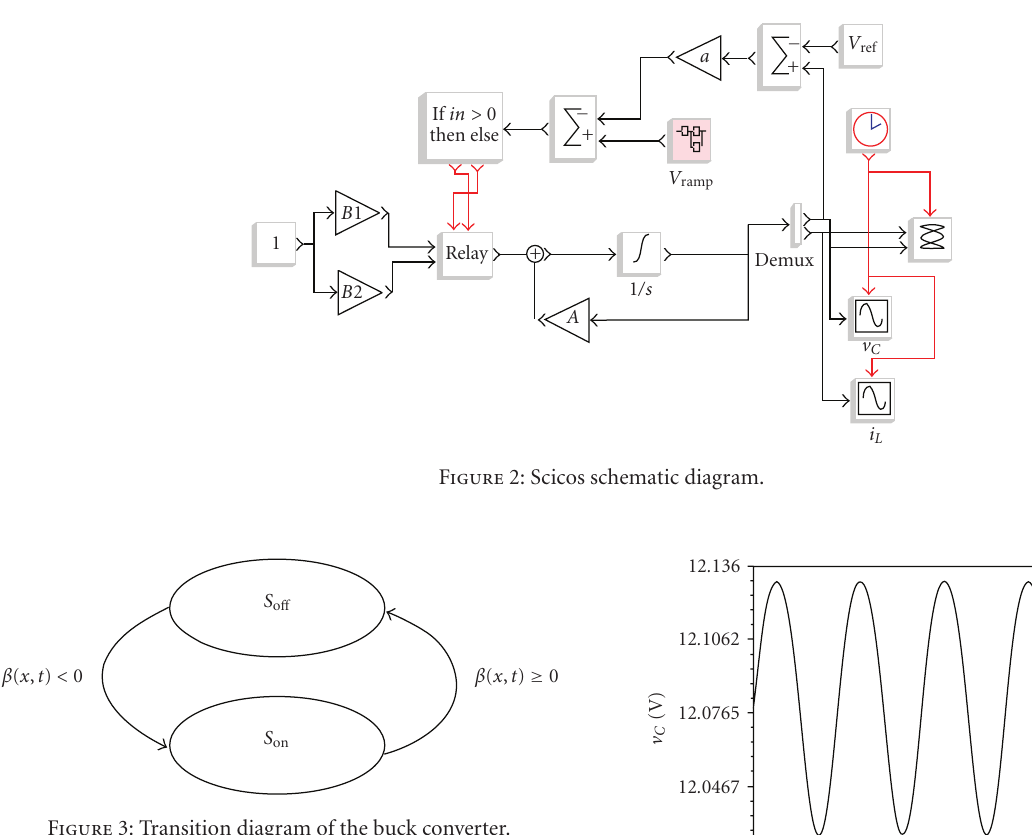
Figure 3: Transition diagram of the buck converter.